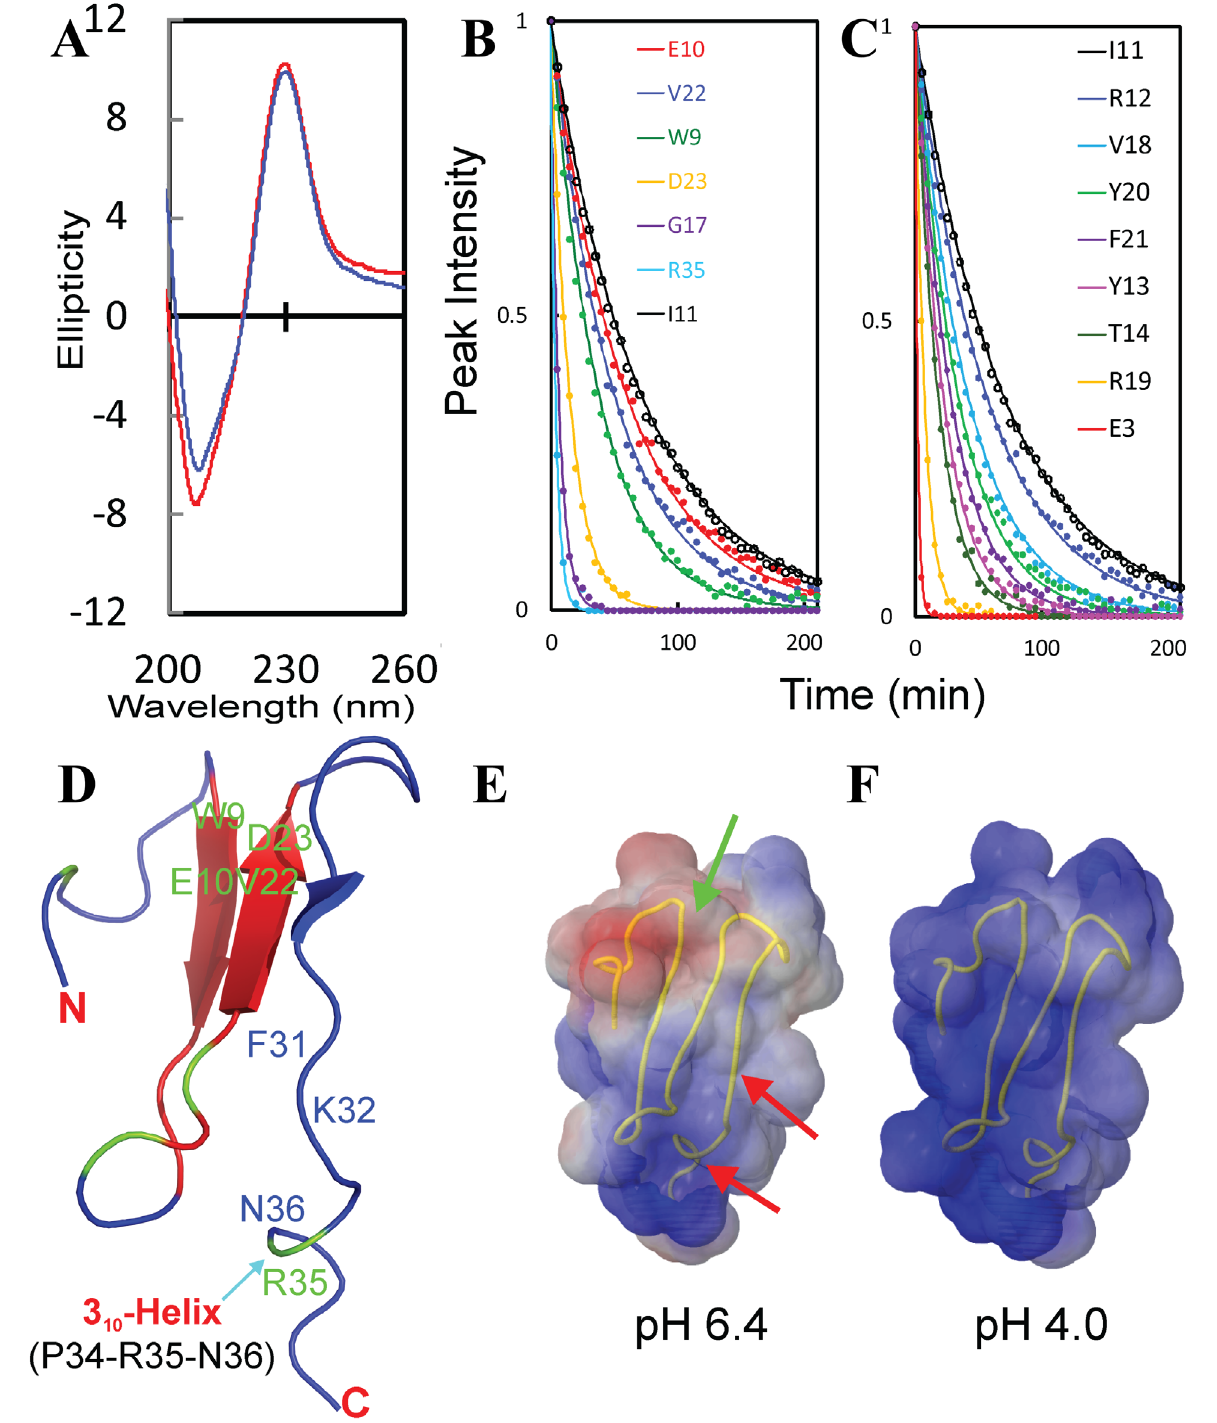
Figure 19. Conformations, accessibility and electrostatic potential surfaces of the well-folded WW4 domain. ( A ) Far UV CD spectra of the WW4 domain (25 µM) in unsalted water at pH 6.4 (blue) and 4.0 (red). ( B )–( C ) Experimental (dots) and fitted (lines) values are shown for HSQC peak intensities in NMR H/D exchange experiments for WW4 residues whose peaks are significantly ( B ) and not significantly ( B ) perturbed by salts. ( D ) WW4 structure colored with H/D exchange rates (Kex): blue for residues with HSQC peaks disappeared in 2 min after the lyophilized sample was dissolved in D O; green for residues with Kex >5 h -1 and red for residues with Kex <5 h -1 . ( E )–( F ) The electrostatic 2 potential of WW4 at pH 6.4 and 4.0 respectively, which is calculated with APBS and visualized at the level of the accessible surface of the protein, with blue and red corresponding to positive and negative potential values